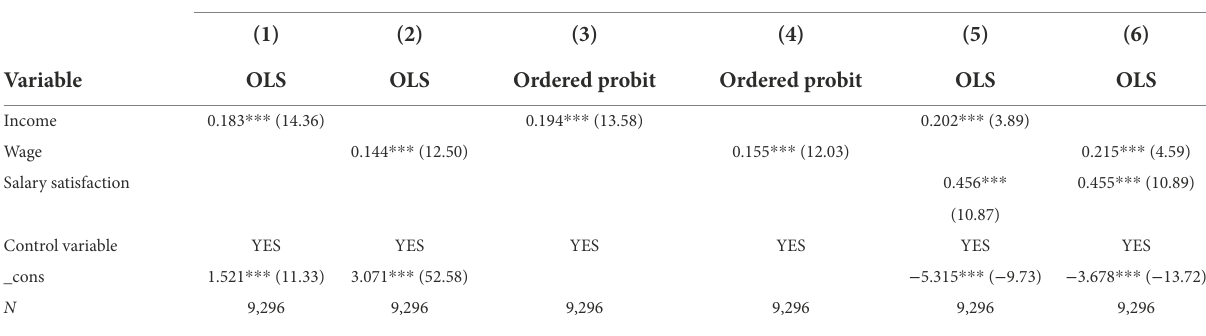
TABLE 8 With salary satisfaction as a mediating